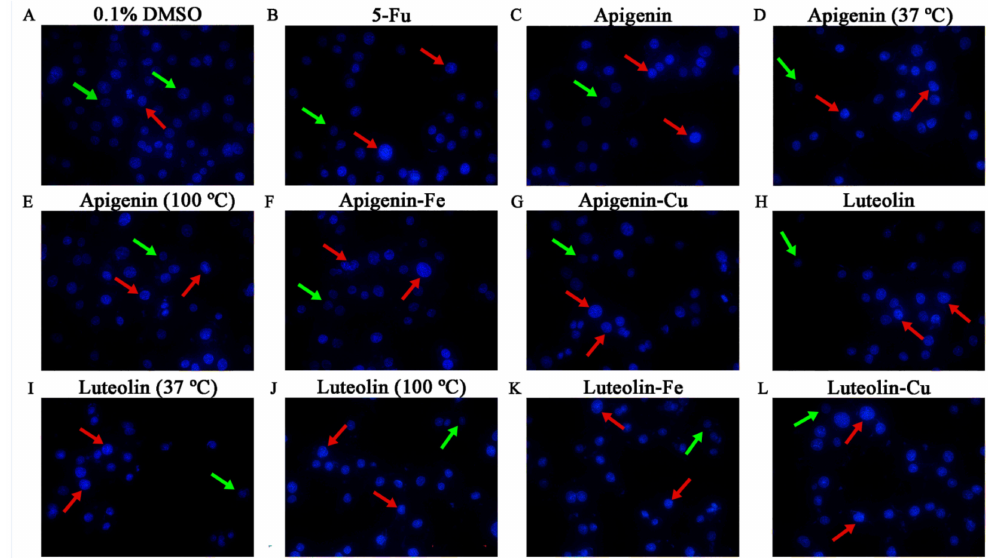
Figure 5. Morphological features of the Hela cells treated with 0.1% DMSO, 100 µ mol / L 5-fluorouracil (5-Fu), and 40 µ mol / L flavone samples (with or without thermal treatment and Fe / Cu addition) for 24 h. A fluorescence microscope was used to photograph images (40 × ). The red and green arrows indicate the corresponding apoptotic and intact cells.